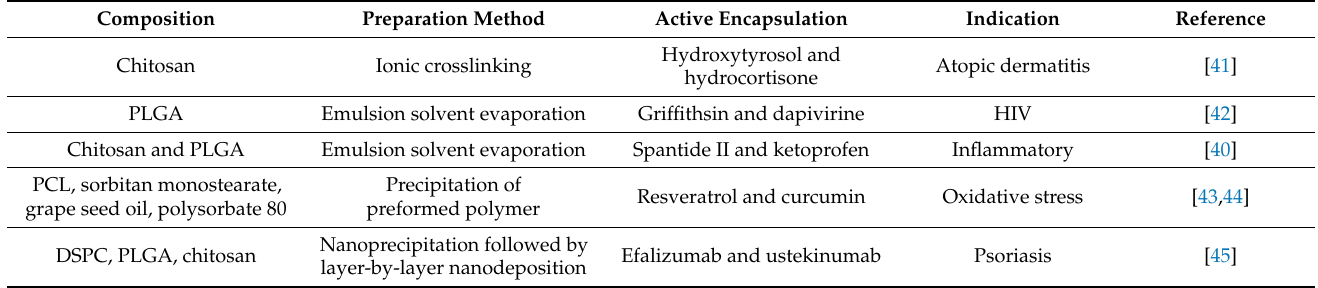
Table 1. Examples of polymeric nanoparticles and the diseases that can benefit from co-encapsulated